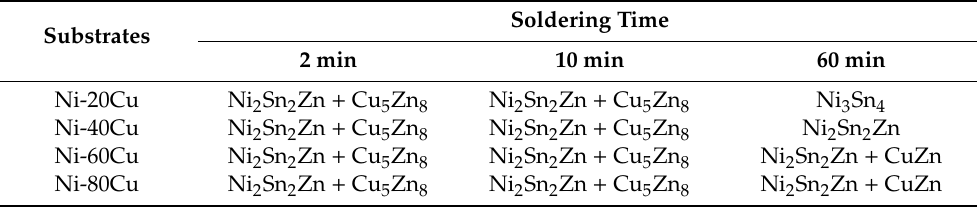
Table 4. Interfacial reaction products of Sn-Zn/Ni-Cu after various durations at 350 °C. Substrates